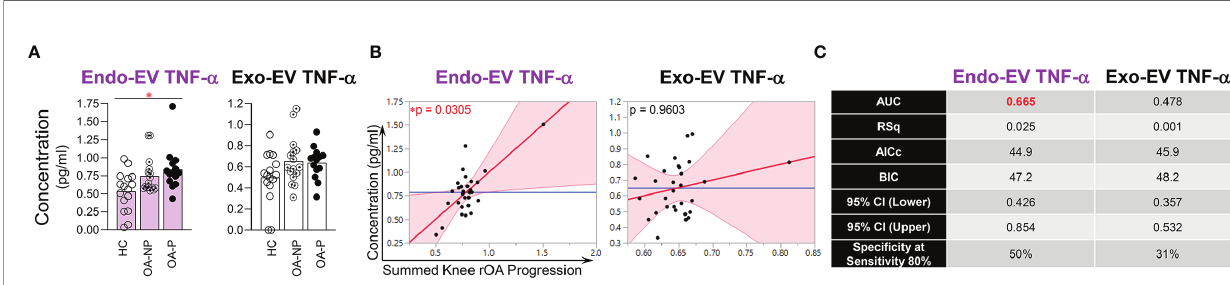
FIGURE 2 | The concentration of endo-EV TNF- a at baseline was associated with knee rOA progression. The concentrations of exo-EV and endo-EV TNF- a in plasma from HC (n = 16), OA-NP (n = 16) and OA-P (n = 14) participants at baseline were measured by multiplex immunoassay. (A) The graphs represent the differential concentrations of endo-EV and exo-EV TNF- a between HC, OA-NP and OA-P. Comparisons between HC, OA-NP and OA-P were performed using Kruskal-Wallis test with signi fi cant results de fi ned by FDR q< 0.05; asterisks indicate the p value as * <0.05. (B) Multivariable linear regression modeling was performed with adjustment for the baseline clinical variables to identify the associations of summed knee rOA progression with baseline concentrations of TNF- a in OA participants (n = 30, 53% OA-NP and 47% OA-P). The Leverage Plots represent plots of leverage of summed knee rOA progression (x axis) vs the baseline concentrations (y axis) of endo-EV and exo-EV TNF- a . (C) Multivariable logistic regression and ROC curve analysis were used to assess AUC and speci fi city (at sensitivity 80%) of endo-EV and exo-EV TNF- a in OA participants (n = 30, 53% OA-NP and 47% OA-P) to predict progression of radiographic knee OA. Rsq, AICs, and BICs were based on likelihood ratio test. 95% bias-corrected con fi dence intervals (CIs) for AUCs are reported. Endo-EV, within EV; Exo-EV, outside EV; HC, healthy control; OA-P, radiographic knee osteoarthritis progressor; OA-NP, radiographic knee osteoarthritis